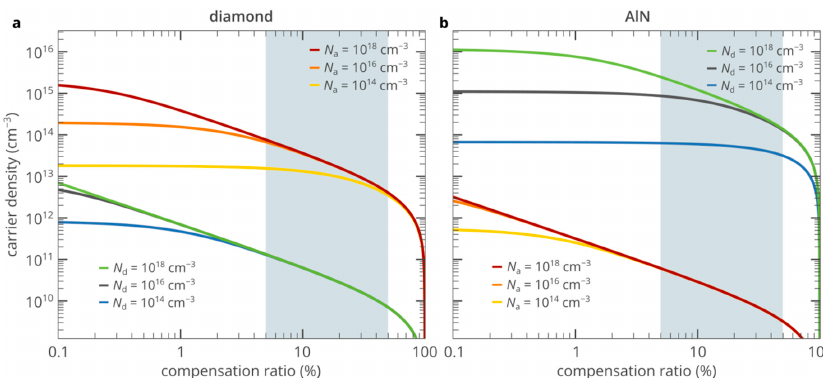
Figure 2. Dependences of the densities of free electrons and holes in the n-type and p-type materials on the donor and acceptor compensation ratios, respectively, for diamond ( a ) and AlN ( b ) at room temperature. Vertical grey stripes show the range of typical compensation ratios in n-type diamond and p-type AlN. The activation energies of donors and acceptors in AlN are 0.25 eV [15] and 0.63 eV [16], respectively. The activation energies of donors and acceptors in diamond are 0.57 eV [17] and 0.365 eV [18], respectively.